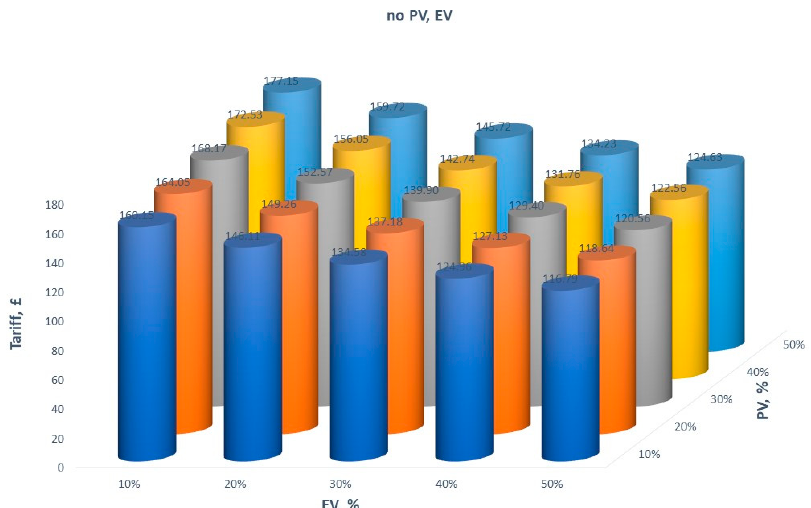
Figure 2. Distribution tariffs for households with PV and no EV. Source: Own results.